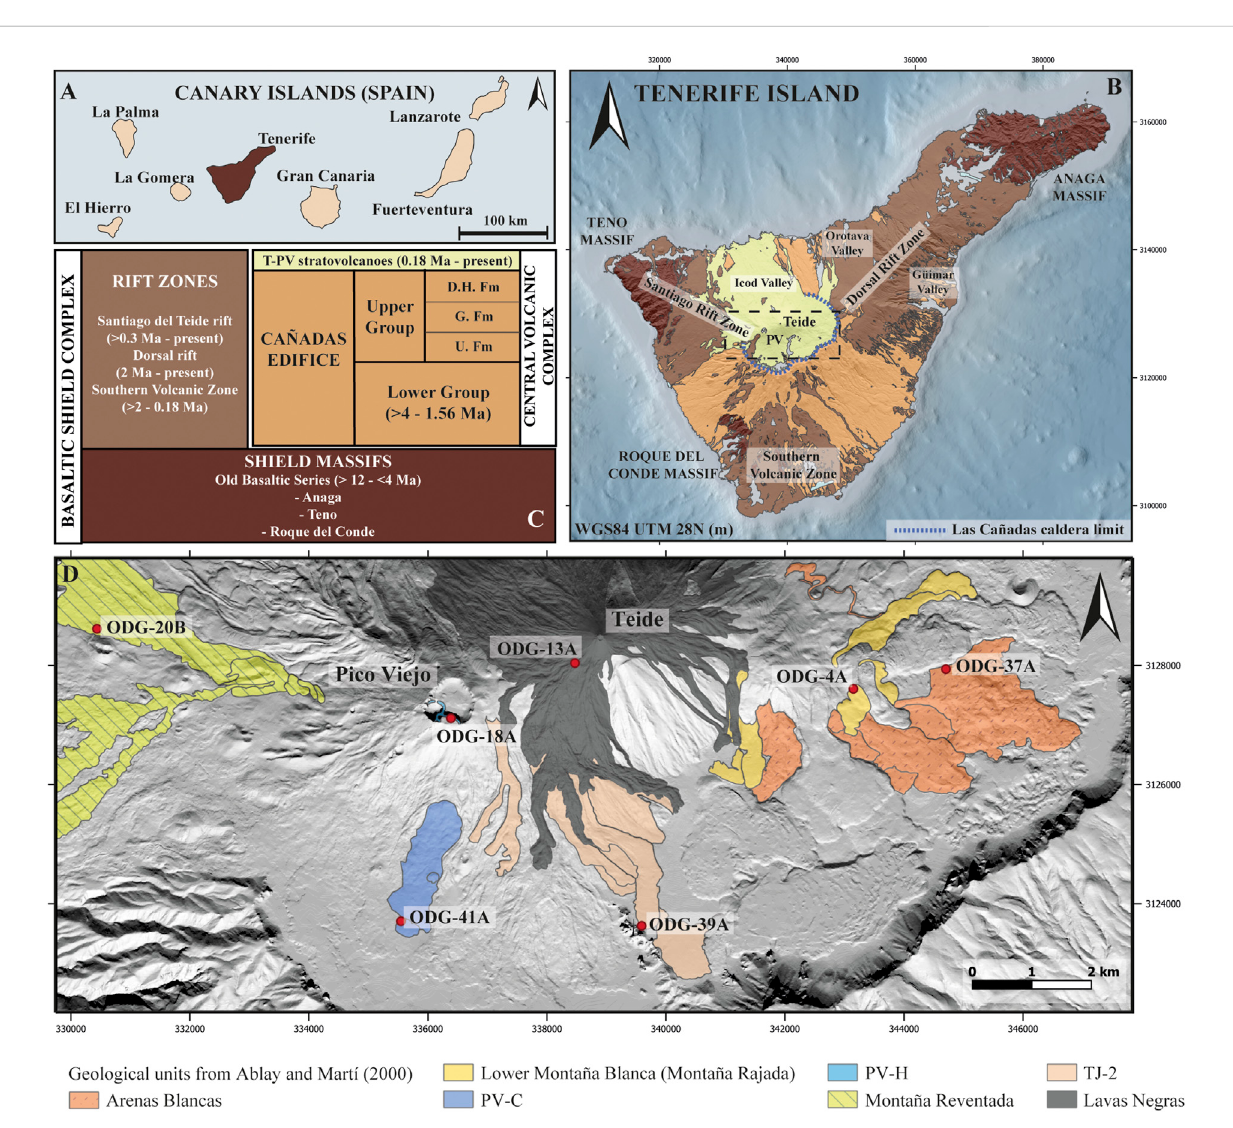
FIGURE 1 (A) Simpli fi ed map showing the Canary archipelago and location of Tenerife island. (B) Simpli fi ed geological map of Tenerife island, modi fi ed from Martí et al. (2008). (C) Simpli fi ed volcanostratigraphy of the main geological units of Tenerife, modi fi ed from Martí et al. (2008). (D) Studied units in